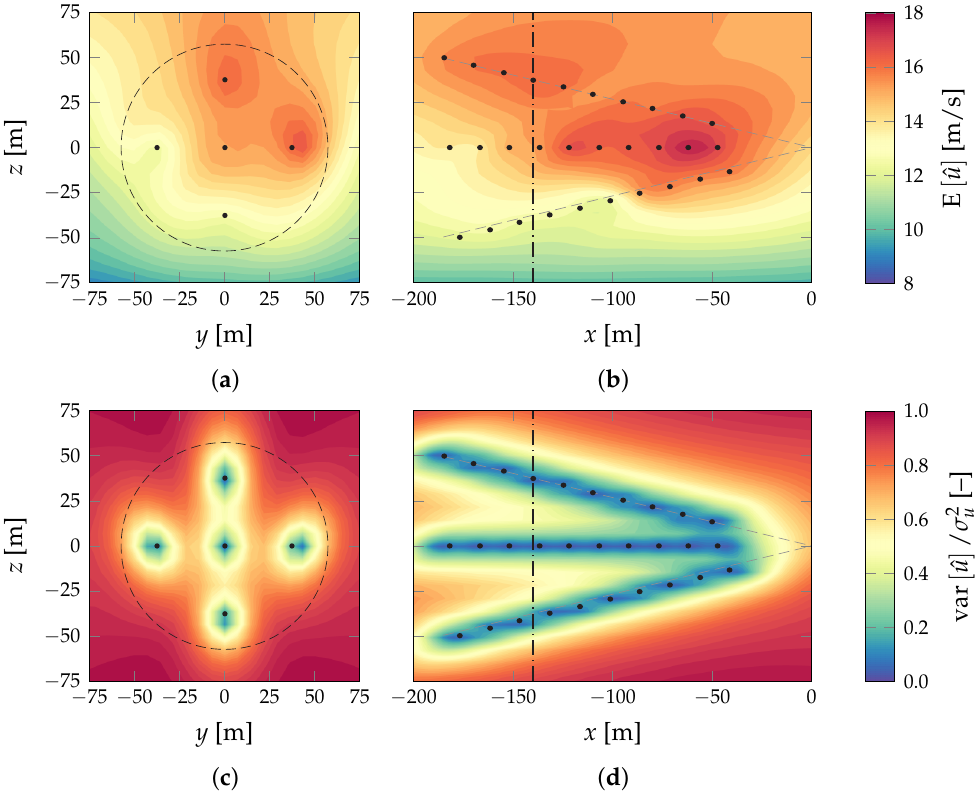
Figure 5. Streamwise velocity fields based on one full cycle of measurements ( n = 50). The dots pinpoint the locations of the individual points, including the distance they are expected to have advected within the 1.25 s measurement period (see Figure 2). ( a ) the expectation of ˆ u ( r , y , z ) (i.e., in the yz -plane at r = − 140 m); ( b ) the expectation of ˆ u ( x ,0, z ) ; ( c ) the variance of ˆ u ( r , y , z ) with respect to the longitudinal variance, σ 2 u ; and ( d ) the variance of ˆ u ( x ,0, z ) with respect to the longitudinal variance, σ 2 u . 2.02.22.42.62.83.0